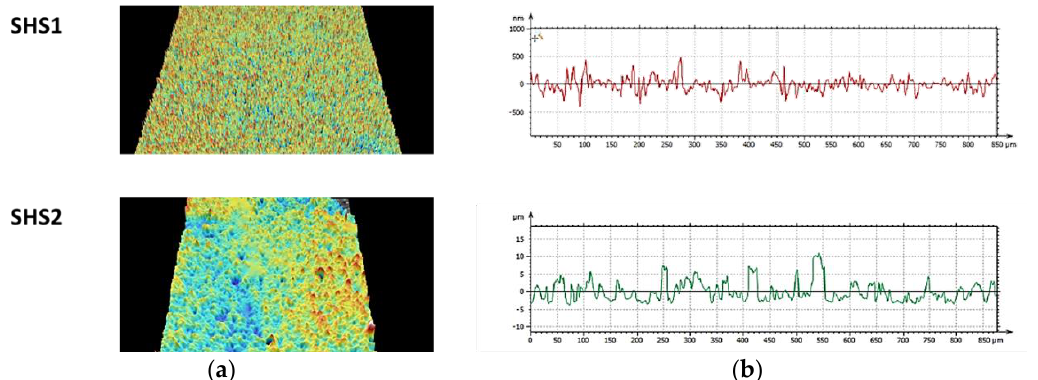
Figure 4. Representative (( a ) 3D images of the two superhydrophobic fabrics ( b ) relative linear profilometry indicating the different roughness scales).